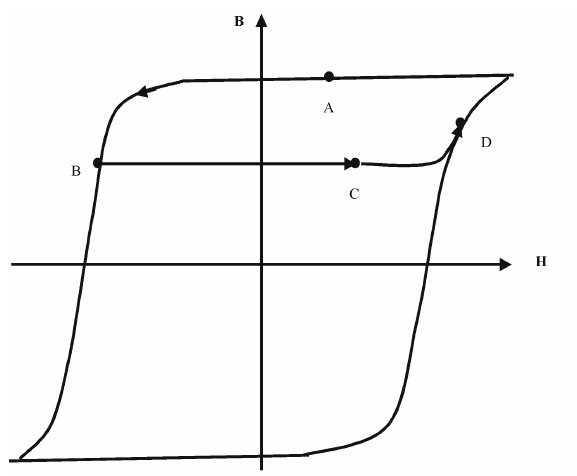
Figure 8: Illustration of Magnetic Recoil